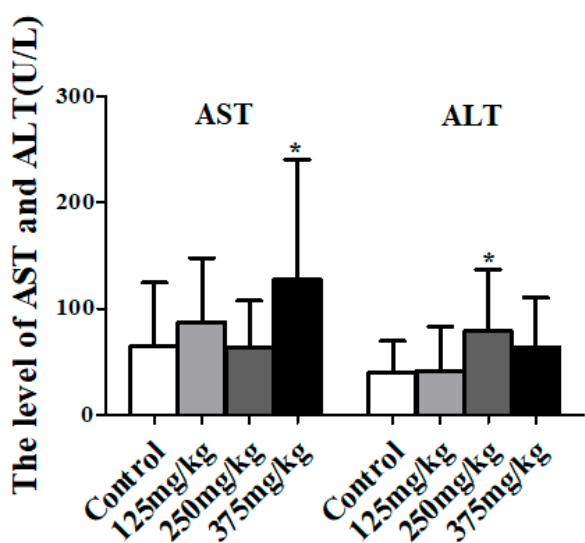
Figure 3. Effect of DEHP exposure on the indicators of liver damage in mice serum ( n = 10). Data shows the activity of aspartate transaminase (AST) and alanine transaminase (ALT), represented as means ± SD, * p < 0.05, ** p < 0.01 compared with the control group.